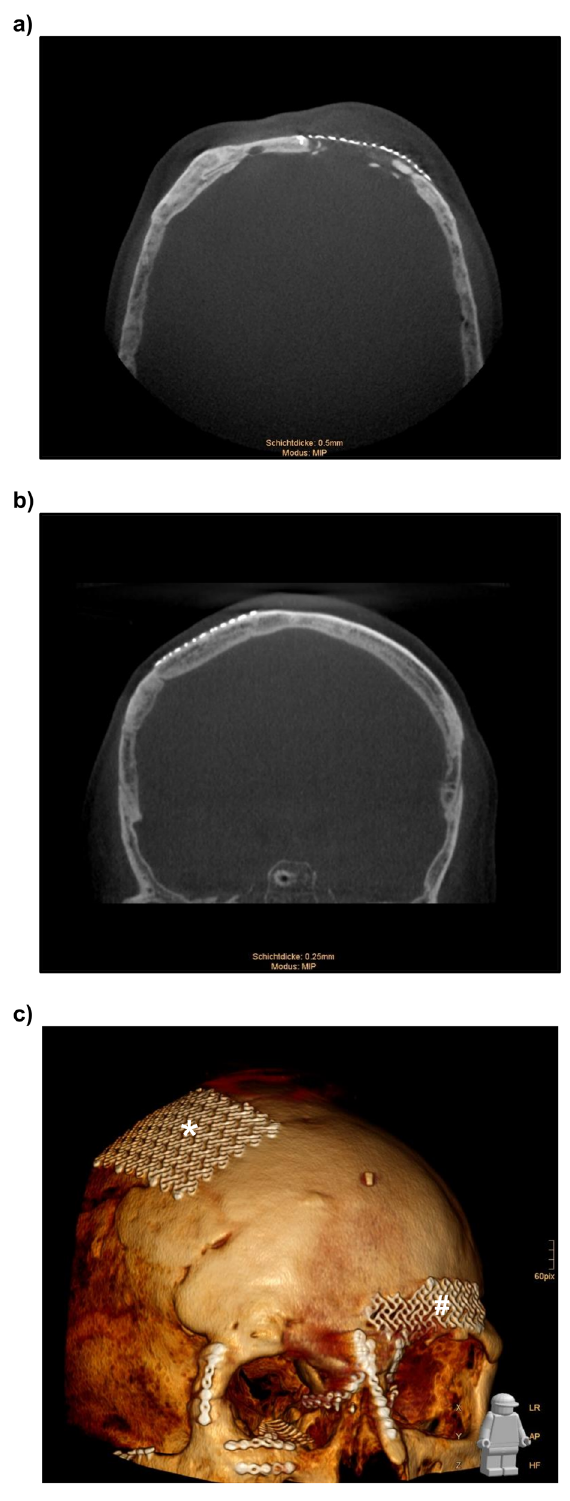
Fig. 1 CT scan of a patient 20 years after fracture treatment of the skull [( a ): axial slice of a frontal sinus fracture; ( b ) coronal slice of a fracture of the parietal bone]. No proper healing can be observed in the frontal sinus area, using only a simple covering with a titanium mesh. c 3D reconstruction of the same CT scan showing the exact location of the two fracture regions in the frontal [#] and parietal [*]